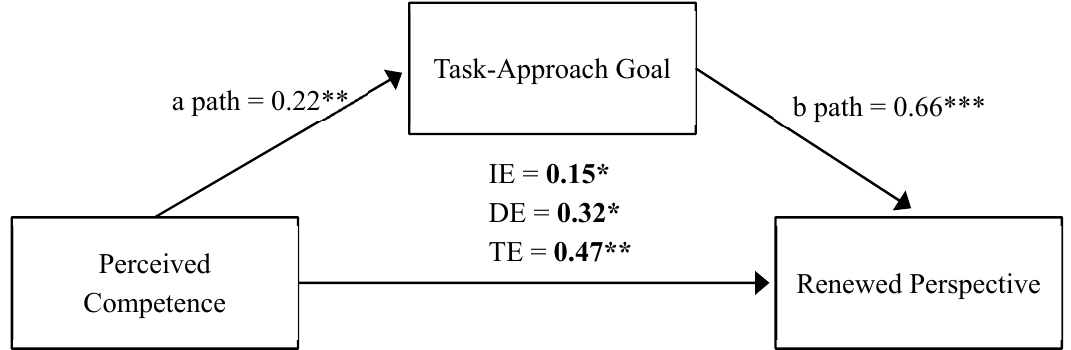
Figure 1. Mediation analysis predicting a renewed perspective. IE = Indirect Effect; DE = Direct Effect; TE = Total Effect; bold indicates statistical significance: * p < 0.05, ** p < 0.01, *** p < 0.001.